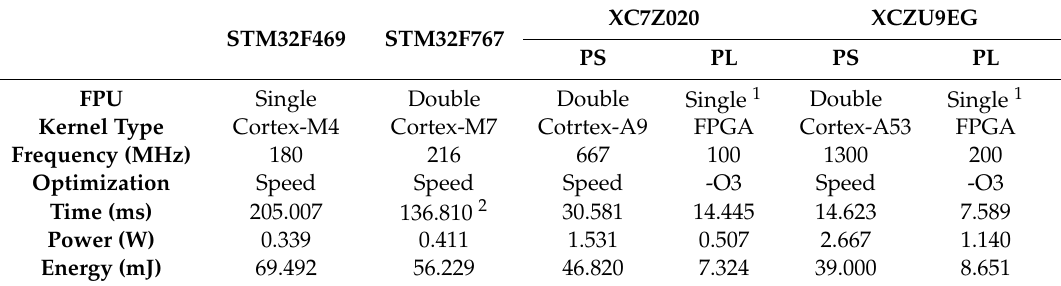
Table 7. Performance with di ff erent